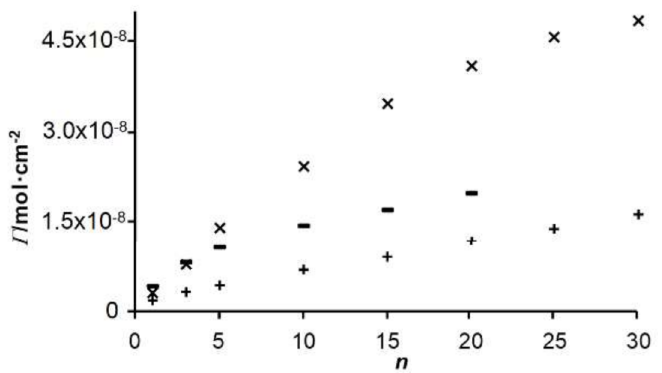
Figure 8. Plots of the apparent surface coverage ( Γ ) vs. the number of electropolymerization cycles ( n ) for: ( × ) poly [Ni(salcnMe)], ( − ) poly [Ni(salcn)], (+) poly